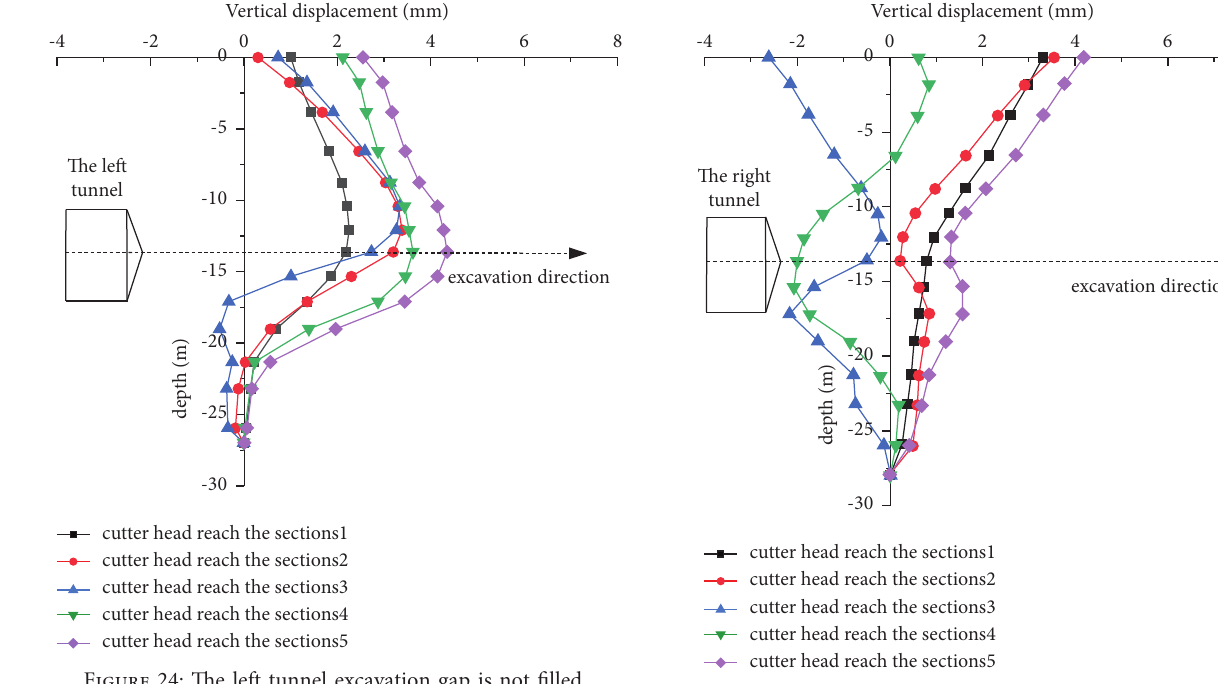
Figure 26: The right tunnel excavation gap is not